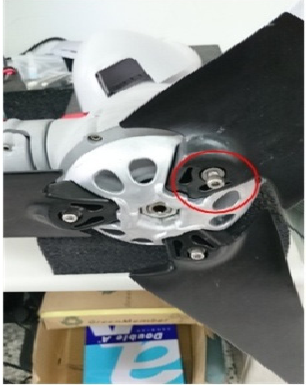
Figure 23. A blade with a loose hug screw.